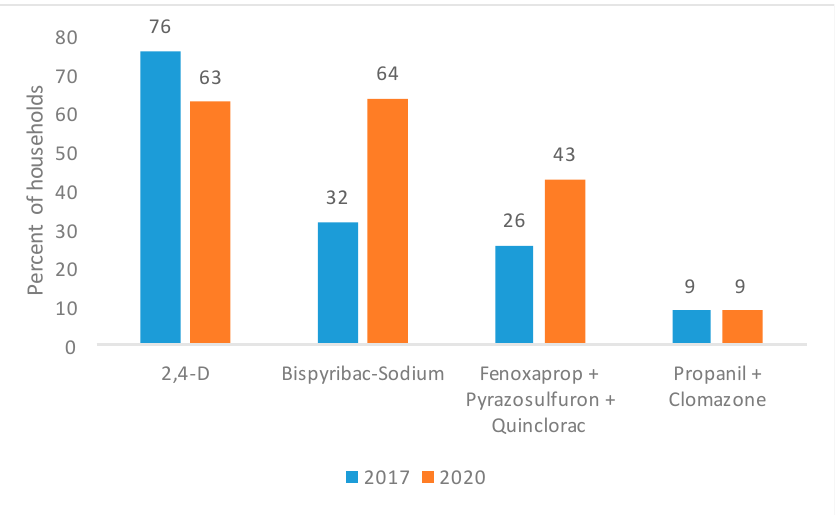
Figure 4. Changes in herbicide use in Boeng Reang, Kampov, Ou Ta Nhea and Rohal Soung villages between 2016–2017 and 2019–2020.